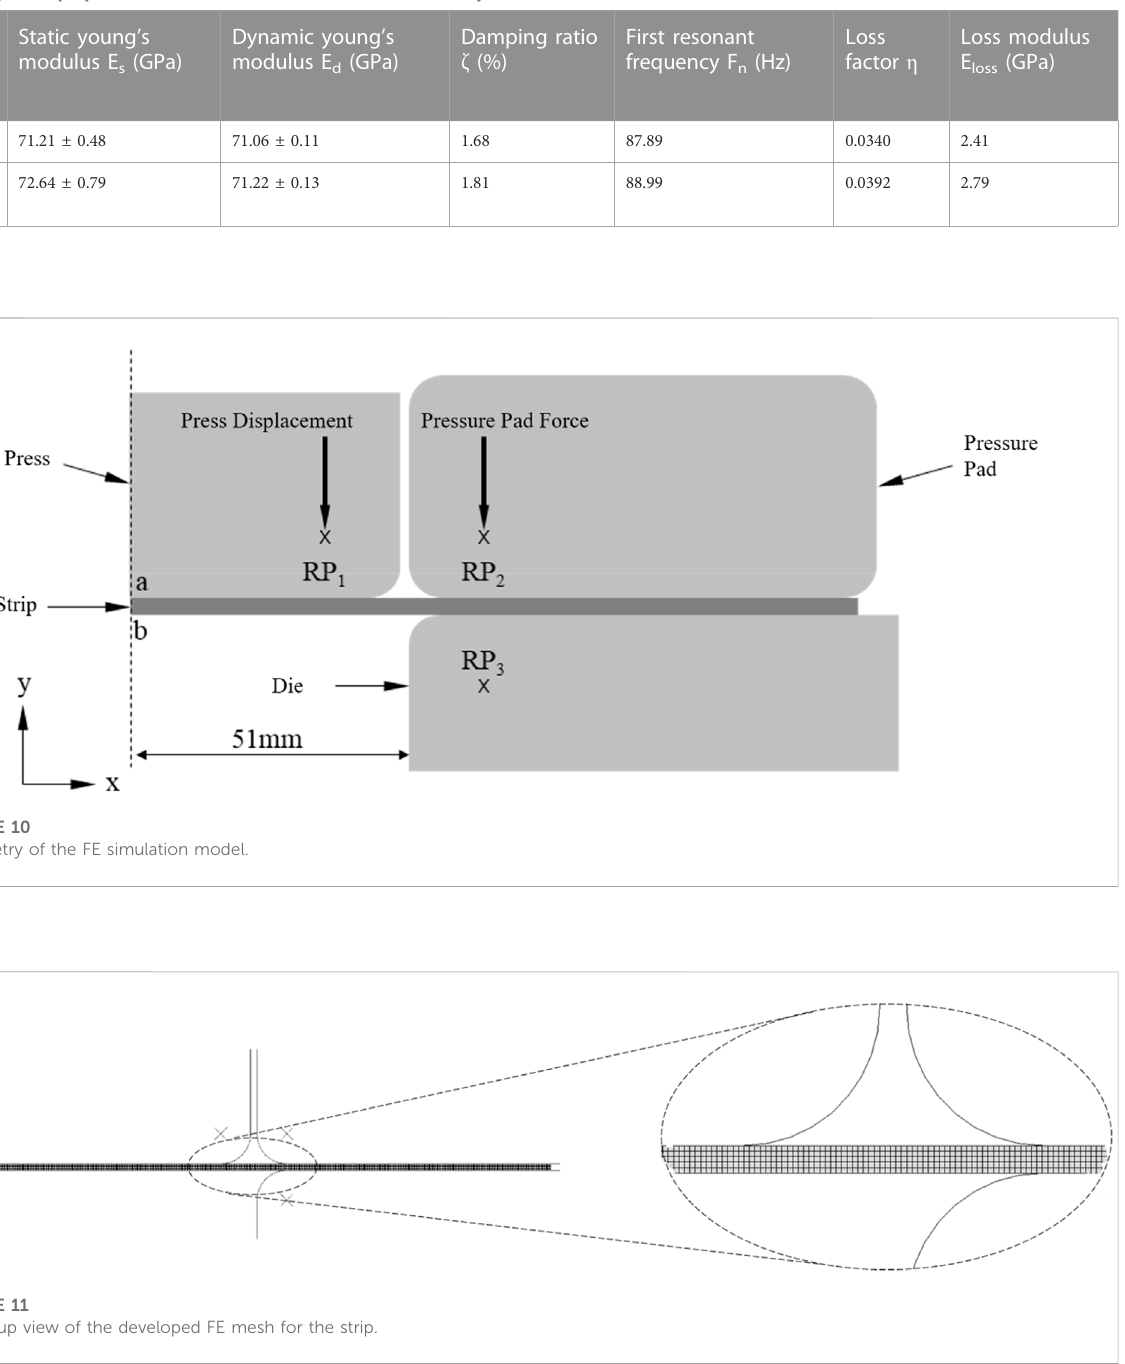
aluminum alloys ’ compressive yield points fall below 100 MPa as the temperature is raised above 250 ° C, while in the standard and modi fi ed alloys, the compressive yield strength was 194 – 230 MPa at 250 ° C. The quality index Q is represented by the equation Eq. 5 and is de fi ned as a semilogarithmic plot of ultimate tensile strength versus